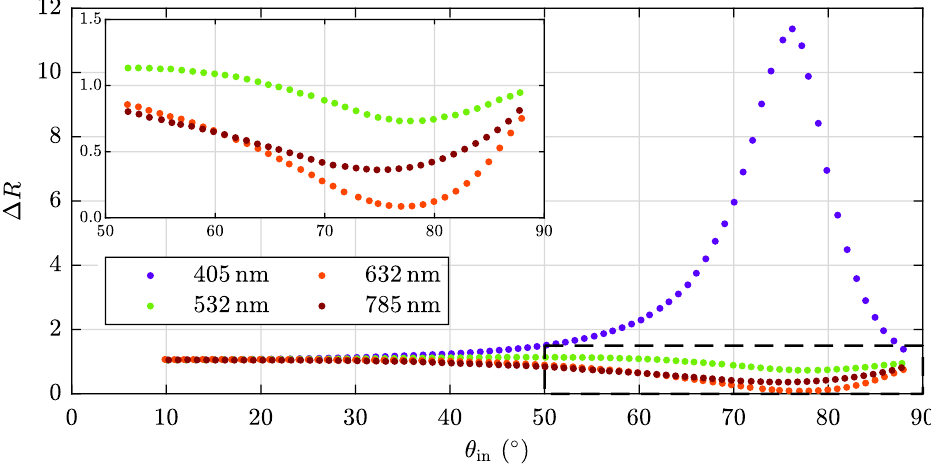
Figure 7. Wavelength-dependency of our measurand ∆ R ( λ ) using the exemplary sample